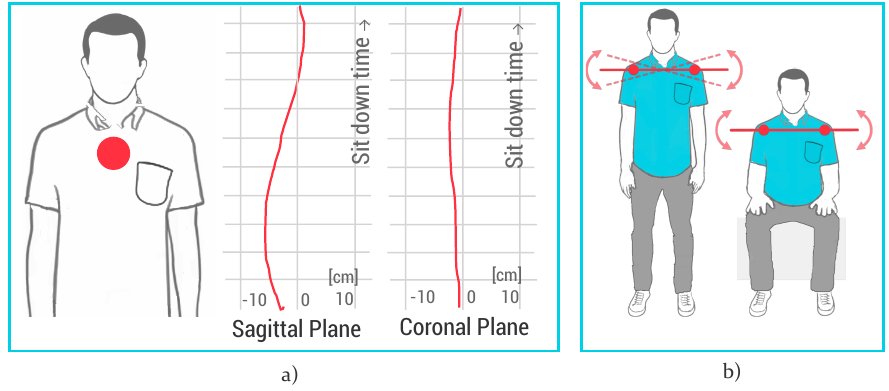
Figure 7. ( a ) Trunk tilt on sagittal and coronal planes; ( b ) Shoulder tilt